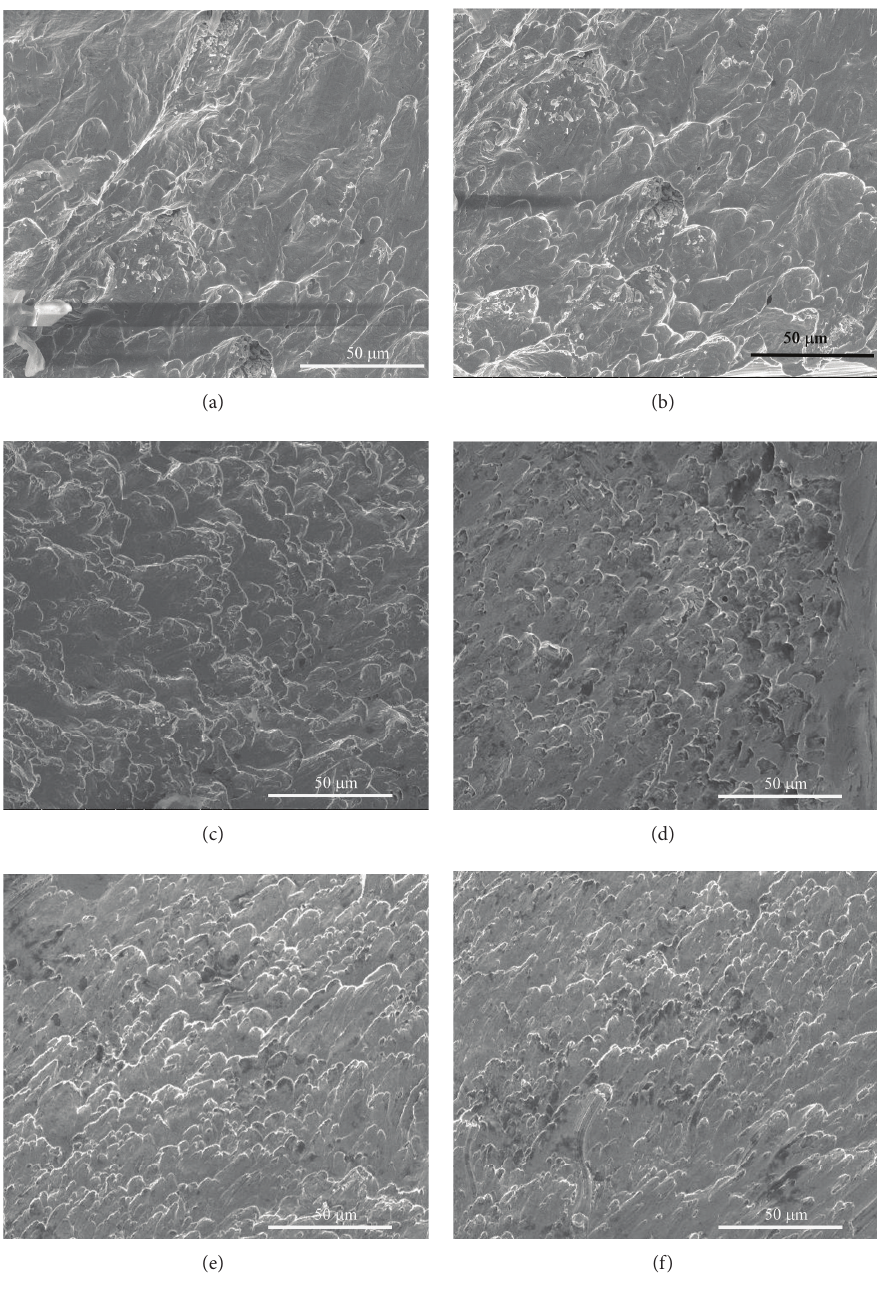
Figure 6: SEM figure of fracture surfaces of specimens deformed at different temperatures and strain rates: (a) − 100 ∘ C, 900 s −1 ; (b) − 100 ∘ C, 2600 s −1 ; (c) 25 ∘ C, 900 s −1 ; (d) 25 ∘ C, 2600 s −1 ; (e) 300 ∘ C, 900 s −1 ; and (f) 300 ∘ C, 2600 s −1